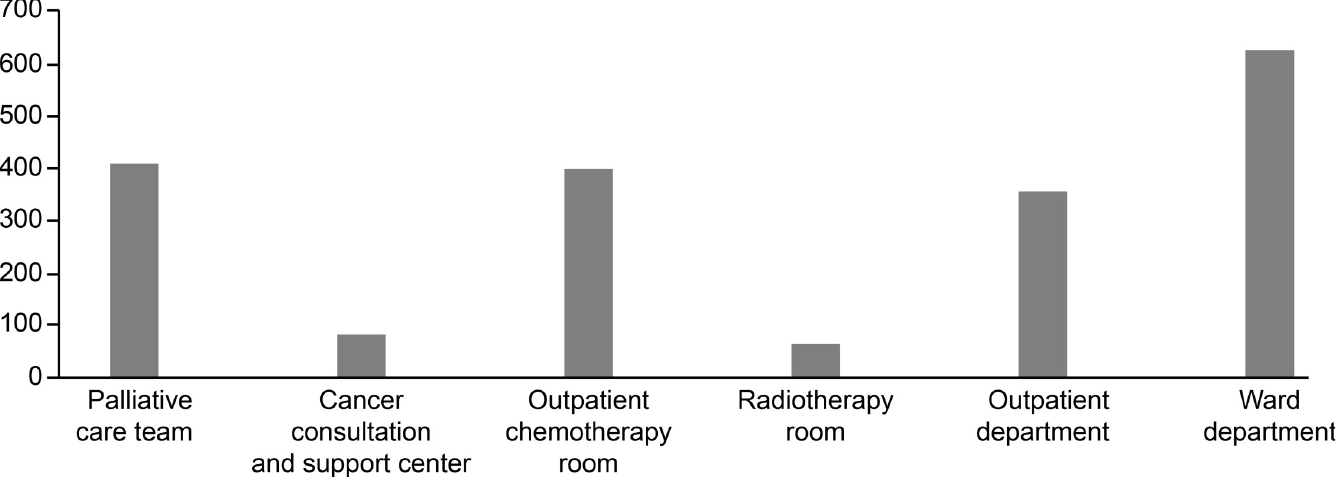
Fig 2. Total number of CNs in each